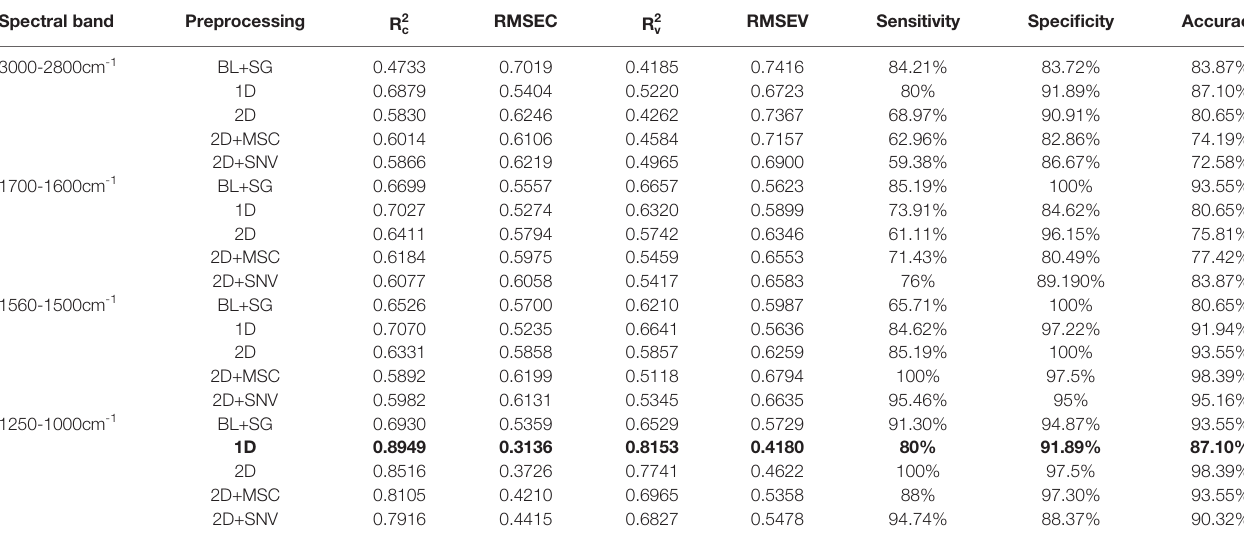
TABLE 3 | Calibration and validation results of PLS-DA for the spectral data after preprocessing.